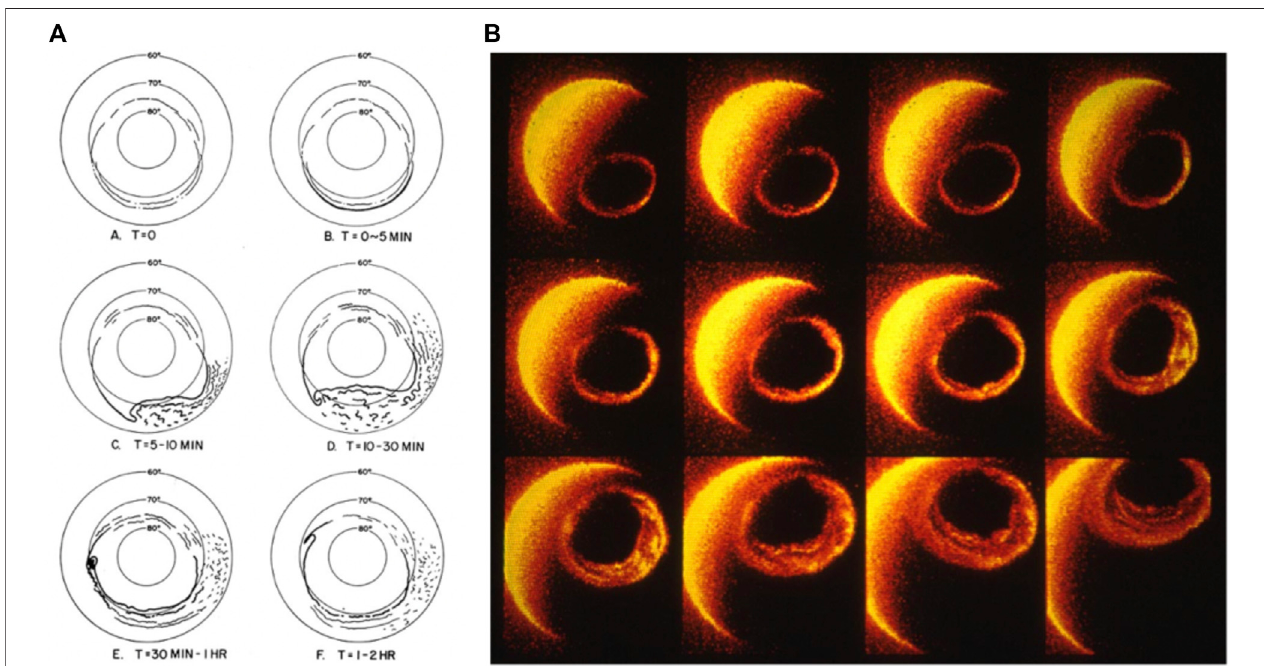
FIGURE5|(A) Theschematicillustrationofthedevelopmentofauroralsubstorms(Akasofu,1964).The fi rstindicationofsubstormonsetisasuddenbrighteningof an auroal arc (T = 0), followed by a rapid poleward advance; this movement causes westward traveling surge (WTS), which propagates toward the evening sky; In the morning sky, the auroral arcs disintegrate into “ patches ” and drift eastward. It takes about 2 h (B) A series of images of an auroral substorm obtained by the Explorer satellite in 1982 (Courtesy of L.